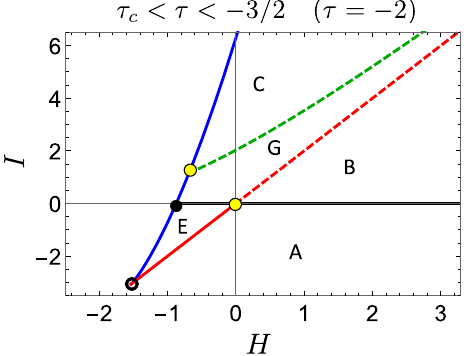
FIG. 18. Bifurcation diagram Σ for the insert strength value τ ¼ − 2 , dividing the ð H; I Þ plane into five distinct regions. The open dot at ð − 3 = 2 ; − 3 Þ denotes the level set containing the pair of pseudo-fixed points, described in Sec. VI A.